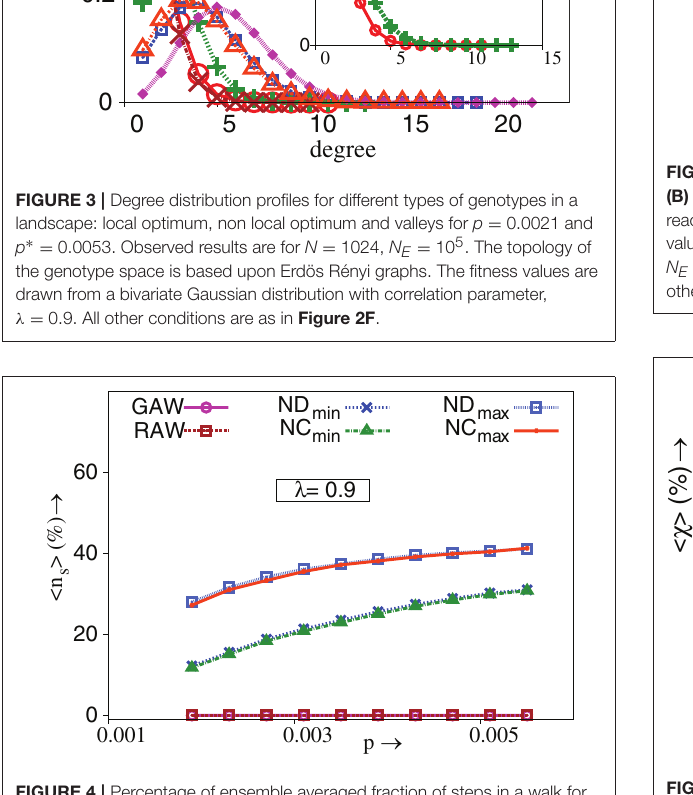
FIGURE 4 | Percentage of ensemble averaged fraction of steps in a walk for which fitness decreases, h n s i , vs. p . TIW are governed by minimum and maximum value of degree ( ND ) and closeness ( NC ) of nodes. λ = 0.9, N = 1024, N E = 1000. The standard error is smaller than the size of the data points. All other conditions are as in Figure 2F .